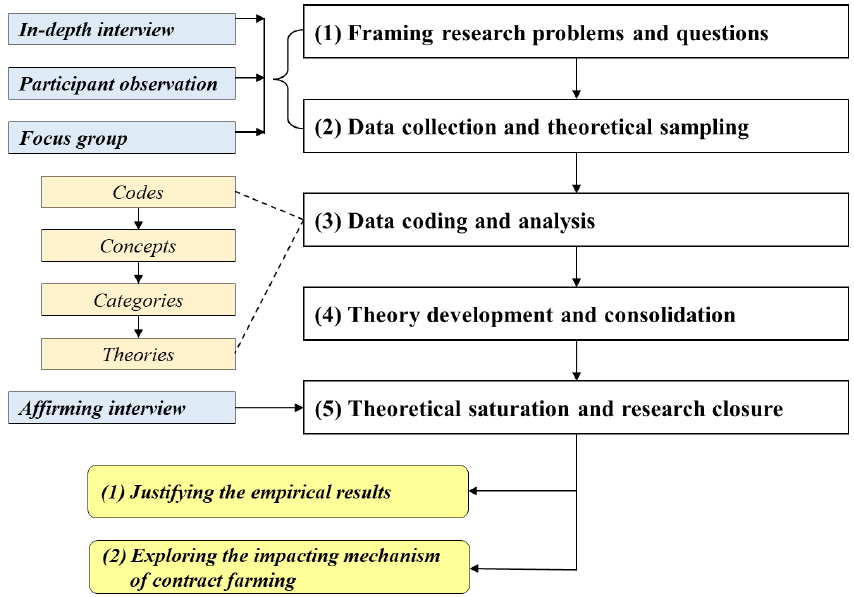
Figure 2. The framework of the theoretical analysis.